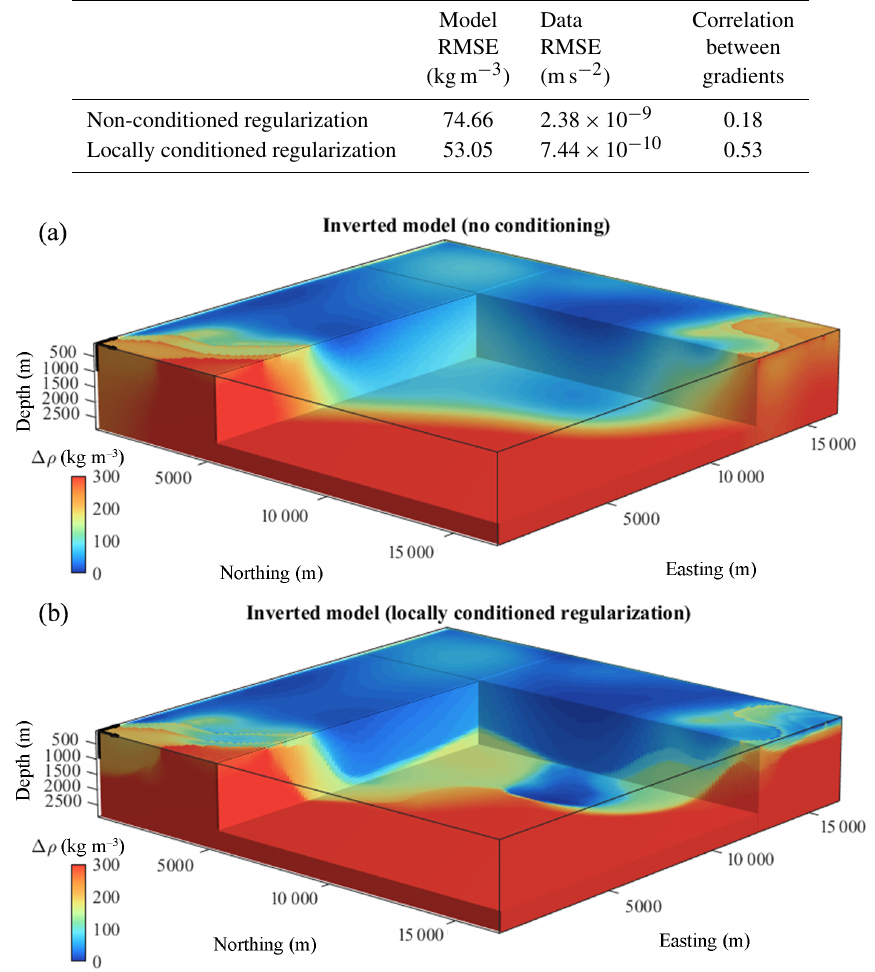
Figure 2. Comparison of inversion results. (a) Inverted models with non-conditioned regularization weights, and (b) using local conditioning.